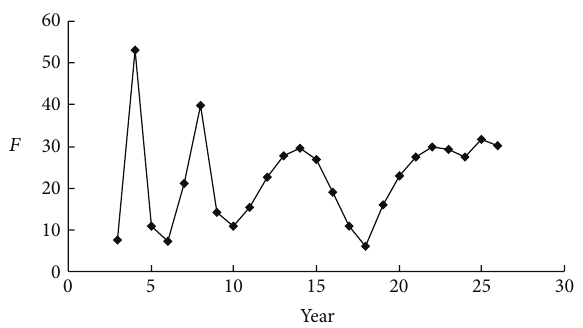
Figure 8: Spectral analysis of the South China spring precipitation.